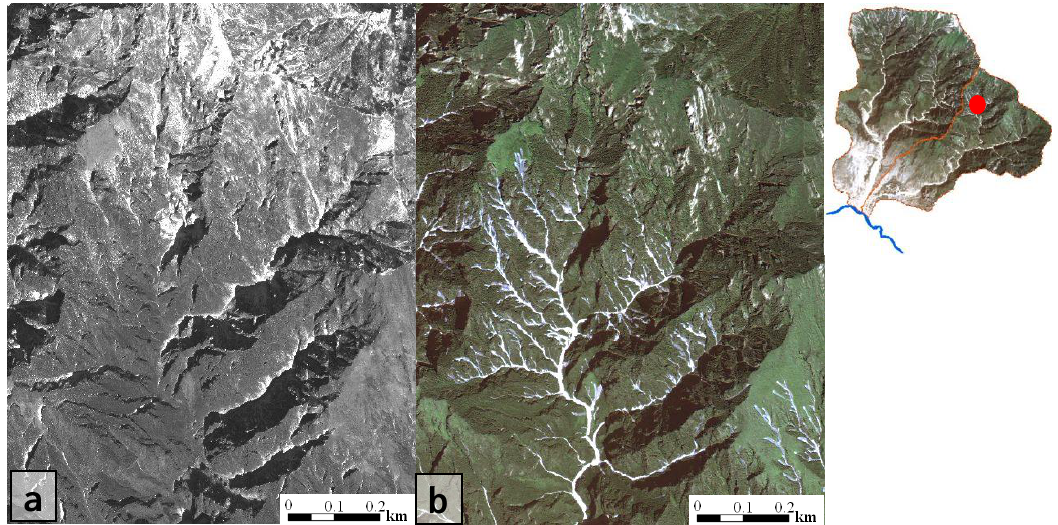
Fig. 5. Imagery showing the debris flow initiation sites of the Luojiayu basin by comparison of imagery prior to and after the rainstorm event ( a : Worldview image taken on 16 May 2010 prior to the event; b : Quickbird image taken on 15 August 2010 after the event). The scoured gullies were considerably widened due to upstream overland flow after the event.